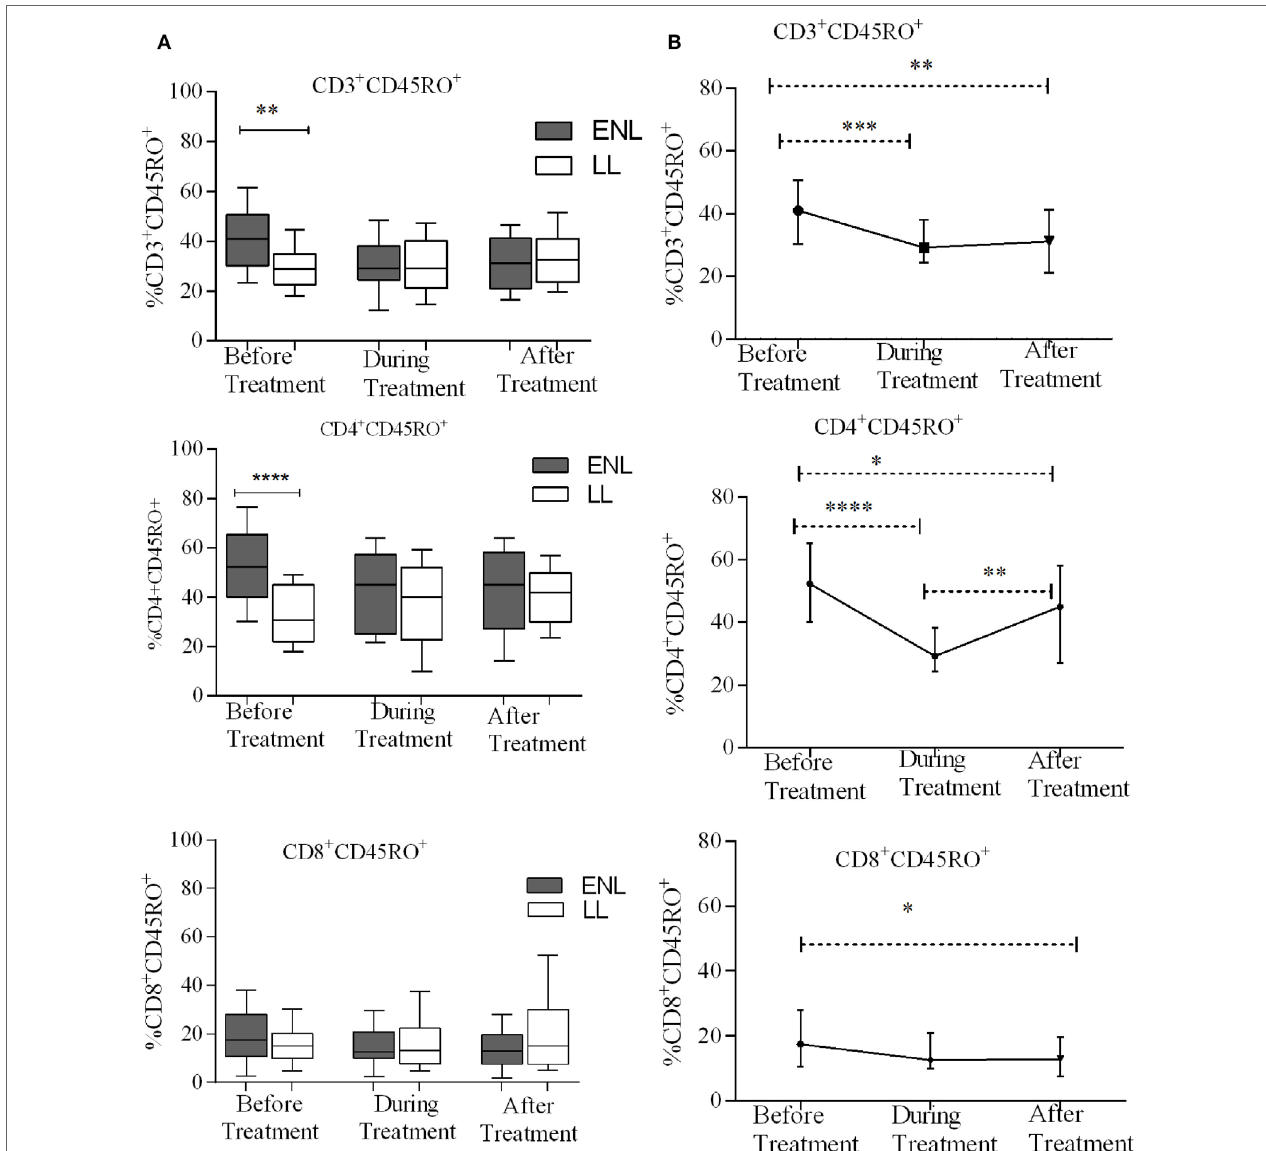
FigUre 3 | Median percentage of total CD3 + , CD4 + , and CD8 + memory T-cells: (a) in patients with erythema nodosum leprosum (ENL) and lepromatous leprosy (LL) controls before, during, and after treatment, (B) within ENL patients before, during, and after treatment. * P ≤ 0.05; ** P < 0.005; *** P < 0.001; and **** P < 0.0001 . Box and whiskers (a) and error bars (B) show median ± interquartile